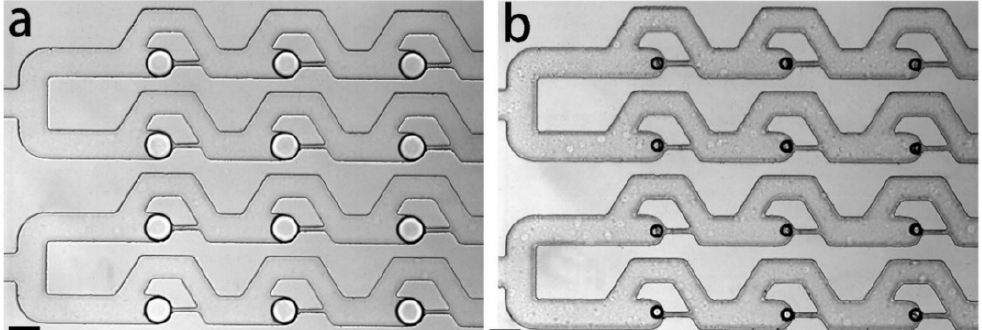
Figure 2. Optical microscope images of the autofluorescent BSA hydrogel microspheres immobilized in microchannels through hydrodynamic trapping ( a ) before and ( b ) after drying. All scale bars are 100 µ m.